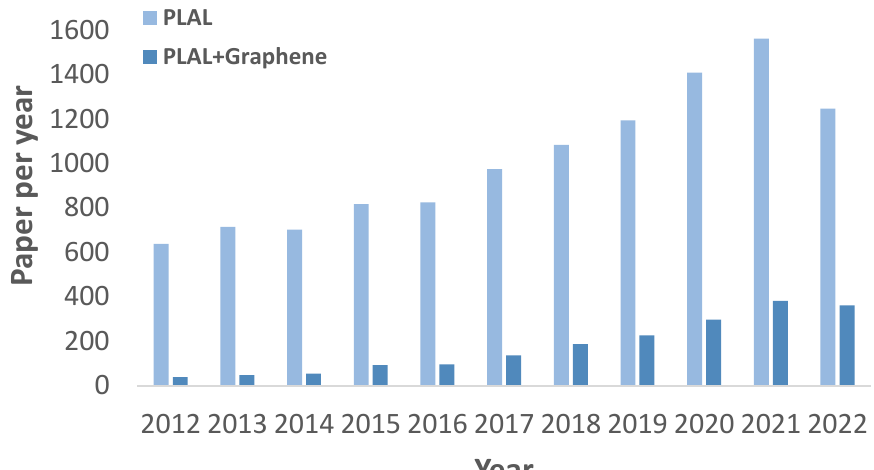
Figure 1. Publications in the field of pulsed laser ablation in liquids (PLAL: general nanostructures, PLAL + Graphene: graphene-based nanostructures via PLAL). Database: Science Direct.